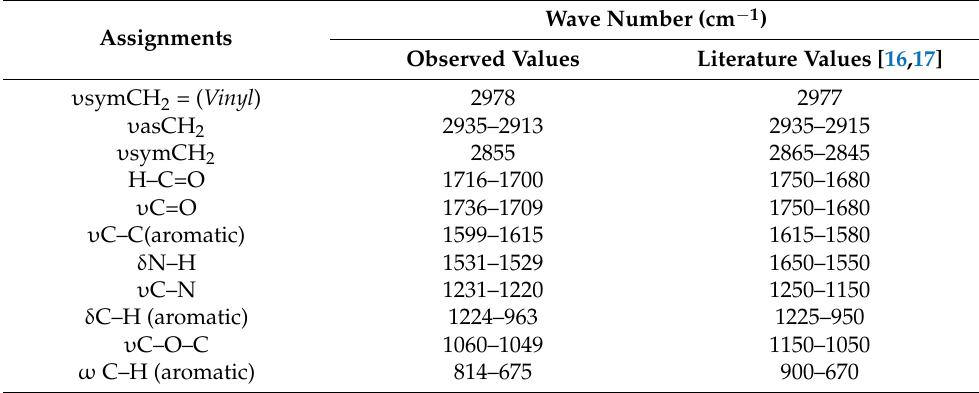
Table 2. Wave numbers (cm –1 ) assignment of Fourier transform infrared (FTIR) spectra of polyurethane.